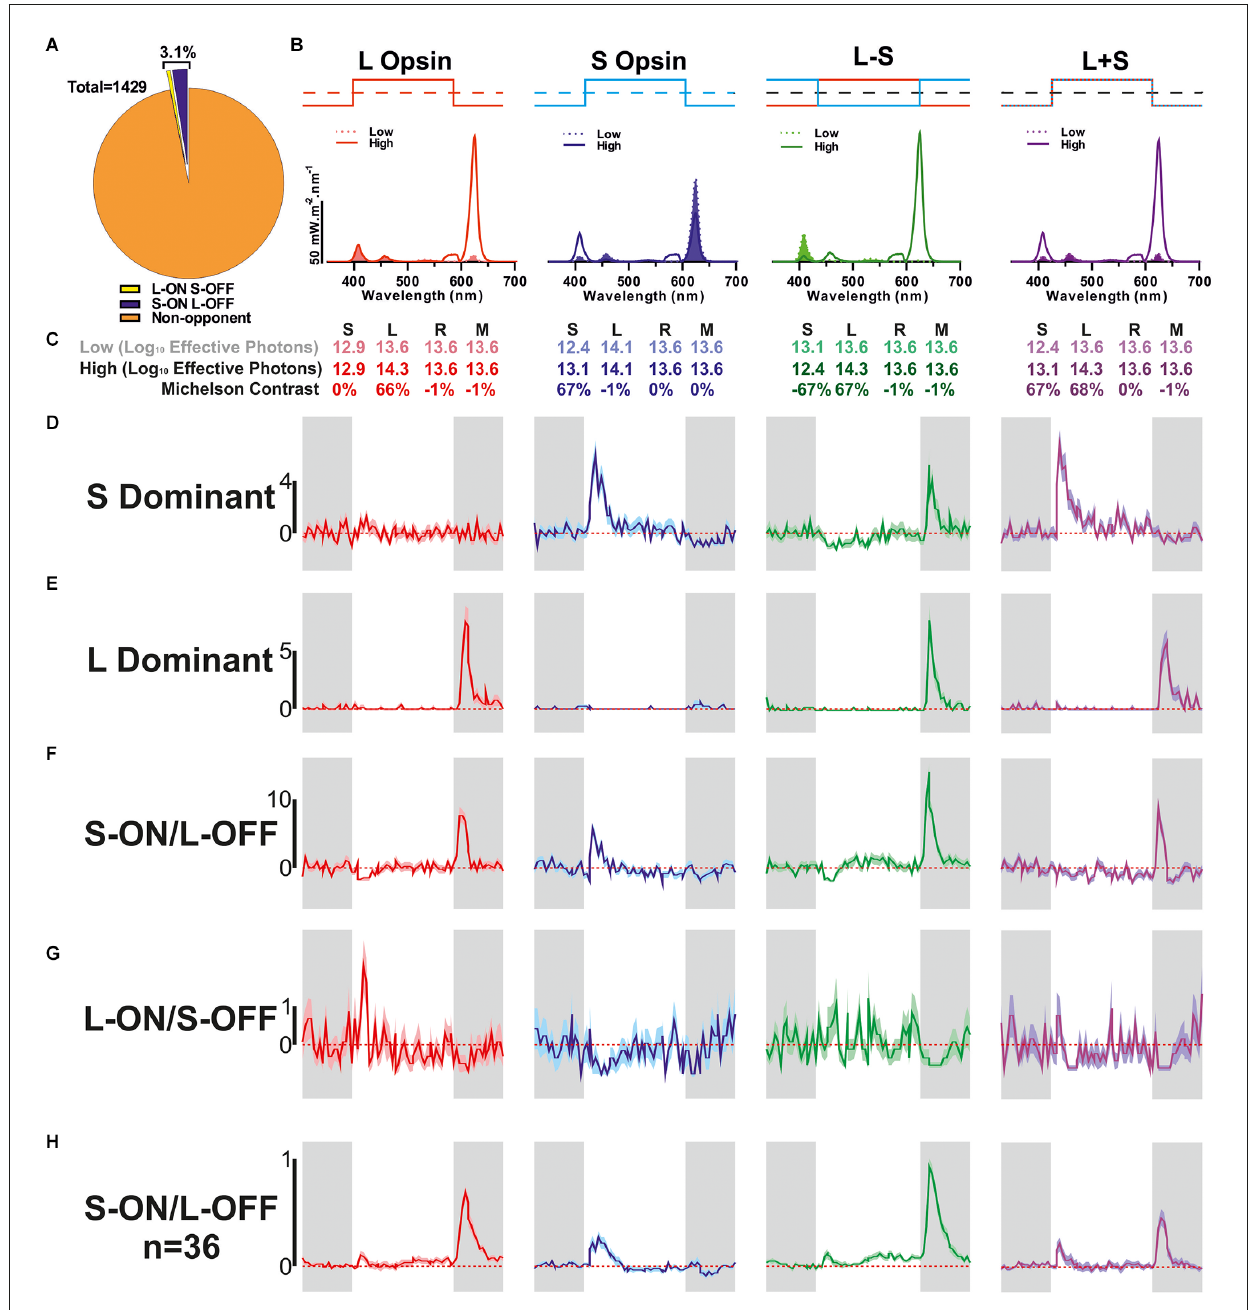
FIGURE1 Detection of colour opponent units. (A) Categorisation of all units that were responsive to 67% Michelson contrast stimuli ( n = 1,429) based on their response to L- and/or S-cone-selective contrast modulation (0.25 Hz square wave). (B) Spectral composition of the stimulus pairs used to isolate cone-based responses. Dashed filled line: low, solid line: high. (C) Relative photon absorbance (log 10 photons) and Michelson contrast for each photopigment under each condition. (D–G) Mean ± SEM responses of example units for each of the cone isolating stimuli shown in (B,C) ( n = 100 trials/stimulus); (D) non-opponent S-ON response, (E) non-opponent L-OFF response, (F) S-ON/L-OFF colour-opponent cell, (G) L-ON/S- OFF colour-opponent cell. (H) The mean ± SEM population response of S-ON/L-OFF ( n = 36) colour opponent cells.